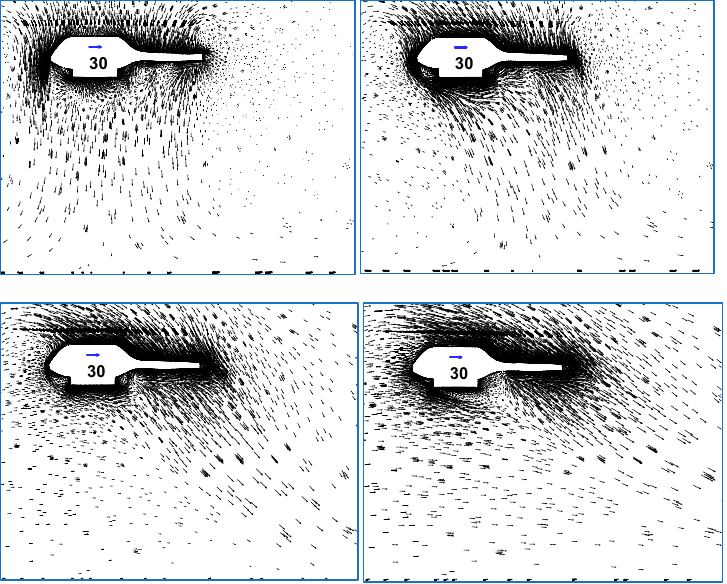
Figure 21. Distribution of wake flow when the helicopter tank bottom was 10 m above the ground (wind speed was 0 m/s, 5 m/s, 10 m/s, and 15 m/s; reference speed marked on the fuselage, indicated by a blue arrow, and the reference speed is 30 m/s).